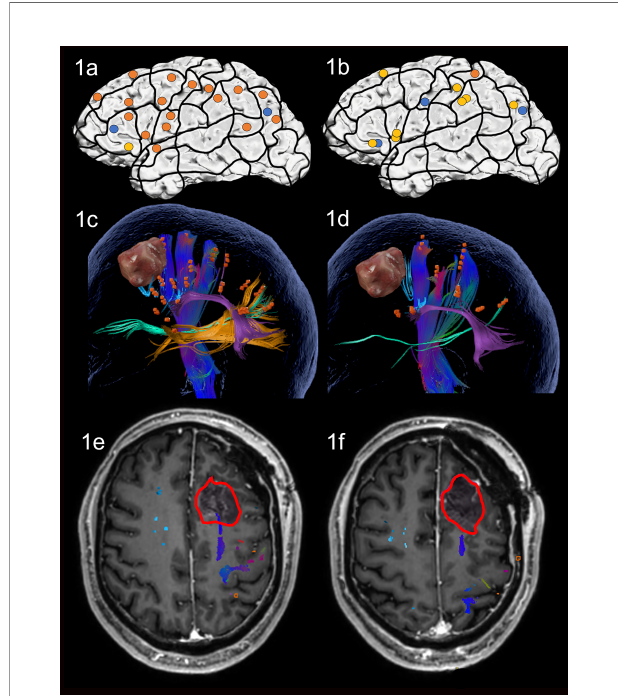
FIGURE 1 | Case 1. Left panels show ON results, right panels AN results. Panels (A, B) nTMS stimulation sites that induced errors; no response and hesitations in orange, semantic errors in yellow and performance errors in blue. Panels (C, D) Fiber tracking results including the lesion, nTMS cortical endpoints in orange and color-coded tracts with CNT in direction-coded, here dark blue, AF in purple, IFOF in turquoise, ILF in yellow, and CF in light blue. Panels (E, F) Overlap of tracking and postoperative T1-weighted imaging after elastic fusion with the resection cavity marked in red.